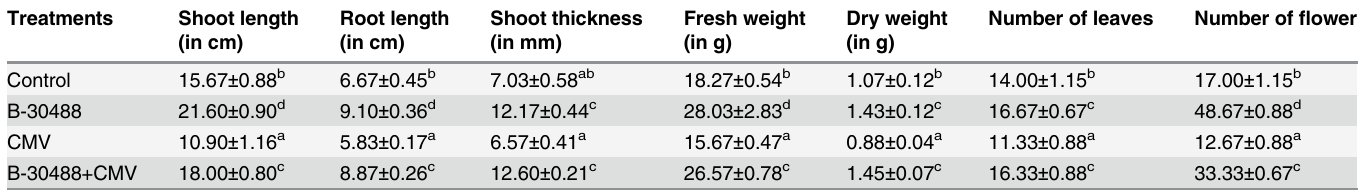
Table 1. Plant growth parameters in control, B-30488 ( P . lentimorbus B-30488), CMV-infected and B-30488+CMV-infected N . tabacum cv. White Burley plants by analyzing the physical parameters (in their respective measurement units). Treatments Shoot length (in